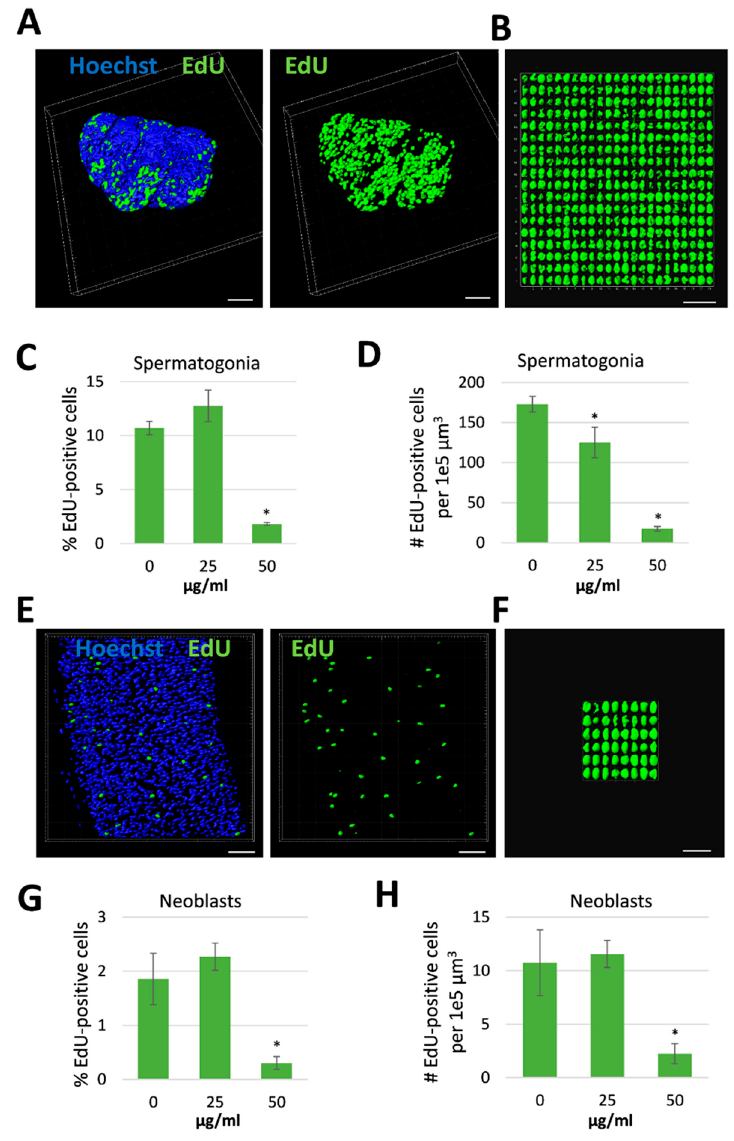
Figure 5. Reduction in stem cell frequency and density in male Schistosoma mansoni treated with Rhynocoris iracundus venom. Worm pairs were treated for 72 h with 25 or 50 µ g / mL of venom or cultured without venom as a control. Proliferating stem cells were labeled with EdU and nuclei of all cells with Hoechst 33342. Cell numbers were quantified in z-stacks using the software package “IMARIS for cell biologists” (Bitplane). The percentage of EdU-positive cells related to the total cell number (C, G) and the number of EdU-positive cells per 1e5 µ m 3 tissue were calculated (D, H). ( A ) Representative images of testes from one worm which was digitally separated from the surrounding tissue using IMARIS. Nuclei are depicted in blue, stem cells in green. Scale bar = 40 µ m. ( B ) All EdU-positive stem cells (spermatogonia) from the testes shown in (A) were aligned and quantified. Scale bar = 25 µ m. The frequency ( C ) and density ( D ) of spermatogonial stem cells in testes were calculated. ( E ) Representative images of parenchyma from one worm after processing with IMARIS. Nuclei are depicted in blue, stem cells in green. Scale bar = 30 µ m. ( F ) All EdU-positive stem cells (neoblasts) from the parenchymatic area shown in (E) were aligned and quantified. Scale bar = 15 µ m. The frequency ( G ) and density ( H ) of neoblasts were calculated. Four worms per treatment group were analyzed. Statistical di ff erences compared to the untreated group are indicated with * p < 0.05 (Wilcoxon rank sum test).